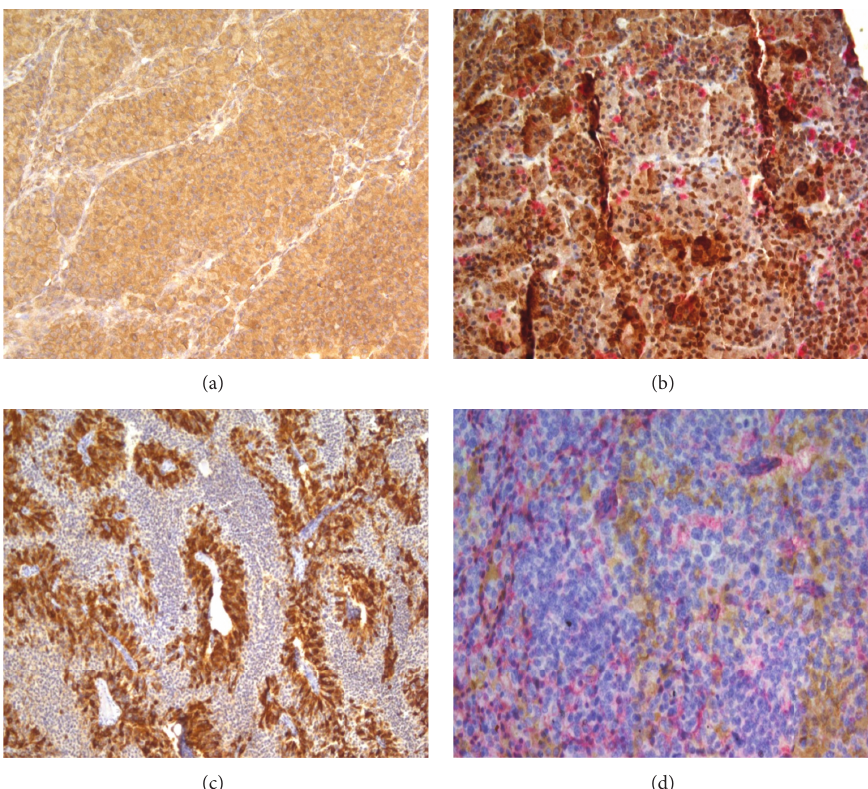
Figure 5: Expression of pituitary tropic hormones in corticotropinomas and ectopic ACTH-secreting tumours. (a) Indirect immunoperoxi- dase staining of corticotropinoma cells with anti-ACTH antibodies, × 20. (b) Indirect double immunoperoxidase staining of corticotropinoma cells with anti-ACTH and anti-LH antibodies, × 20. (c) Indirect immunoperoxidase staining of atypical lung carcinoid cells with anti-ACTH antibodies, × 10. (d) Indirect double immunoperoxidase staining of atypical carcinoid cells with anti-ACTH and anti-CRH antibodies, ×